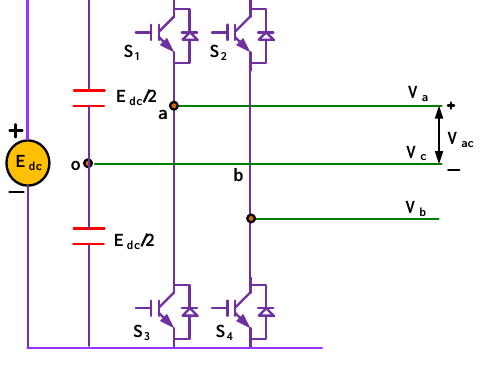
Figure 3. Schematic of